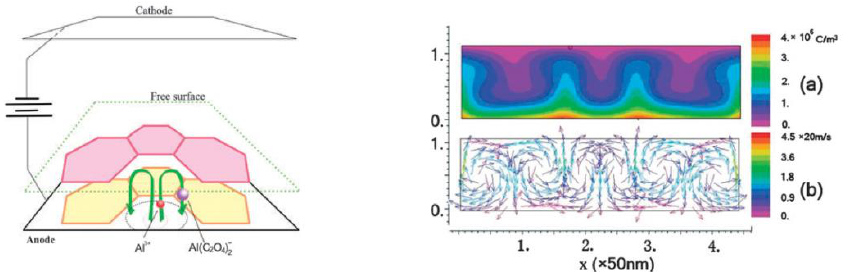
Figure 22. Schematic representation of the nano-convection process driven by electrostatic forces in the vicinity of the oxide/electrolyte interface assumed in the model proposed by Lu et al. (left image), and a numerical solution showing the density distribution of cations Al 3+ and H + and a vector plot of velocities (( a ) and ( b ) in the right image, respectively). Reproduced with permission from [146]. Copyright 2009 The Royal Society of Chemistry.